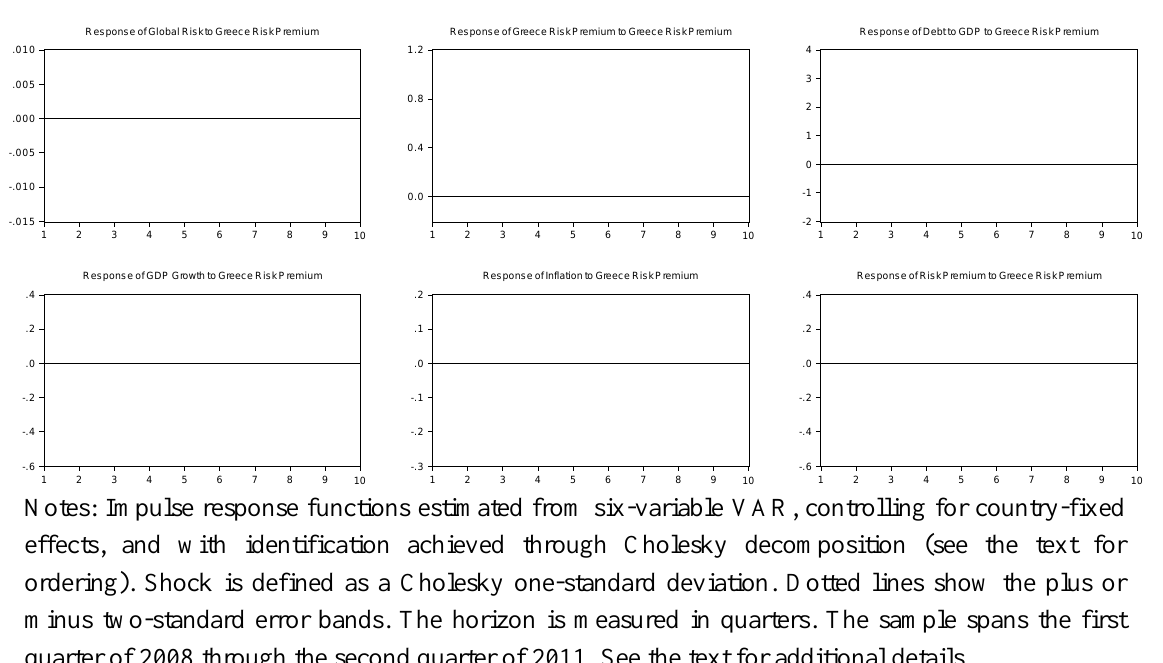
Figure 8. Response of EMU countries to a shock to Greece’s risk premium during the crisis: